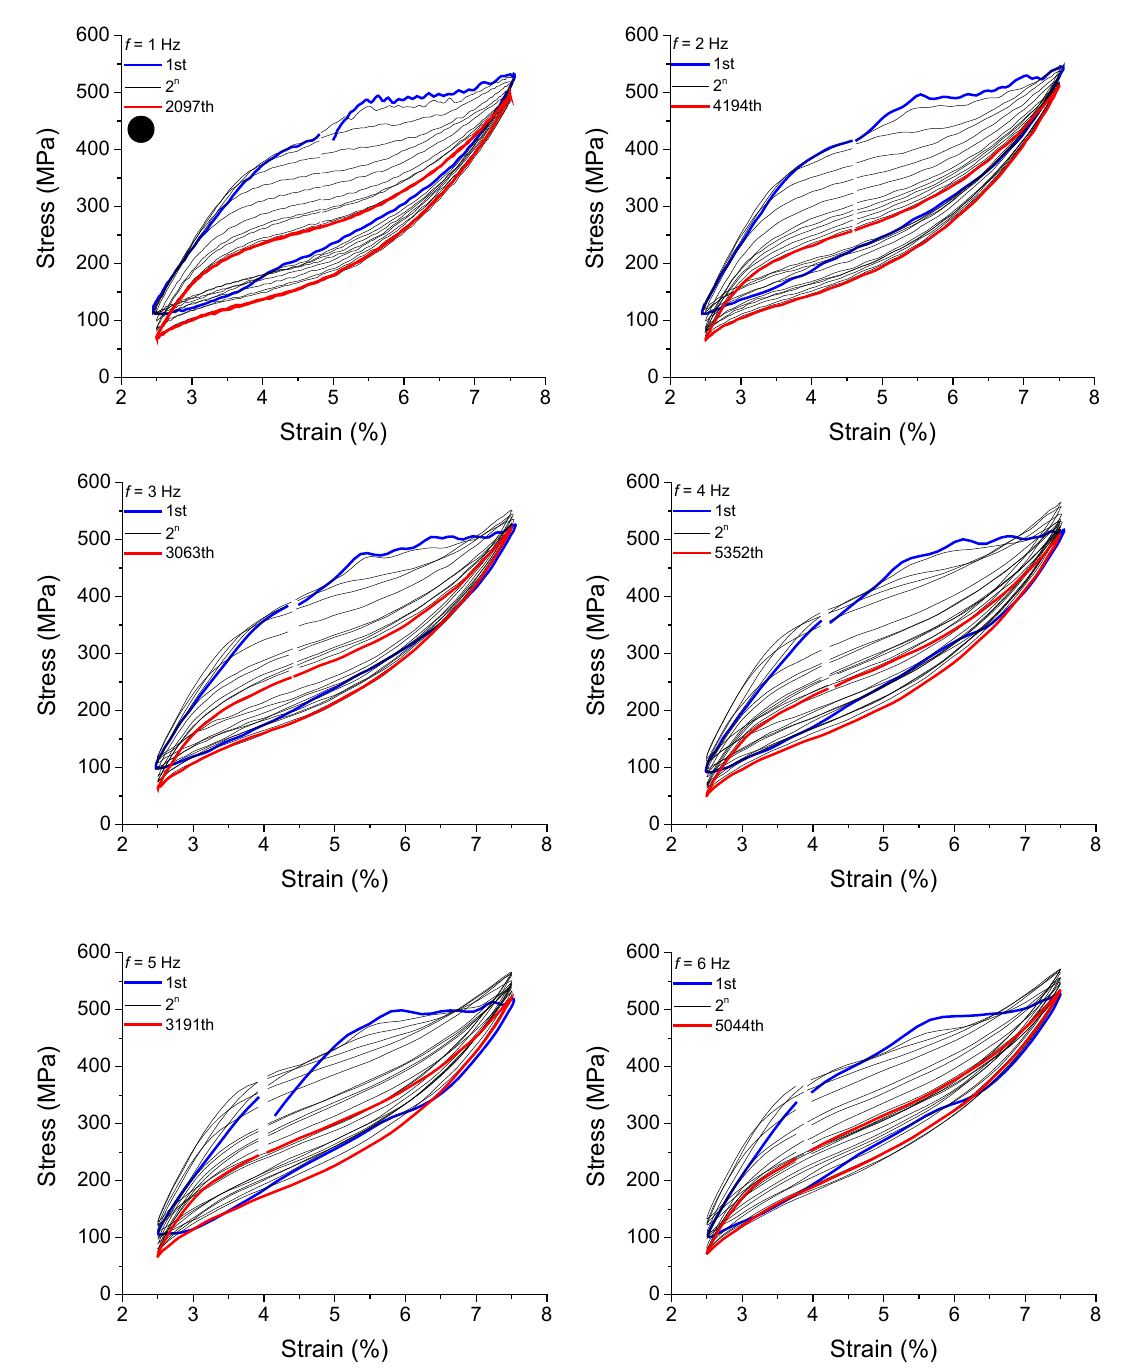
Figure 17. Stress vs. strain superelastic response of the reference element for loading frequencies from 1 Hz to 6 Hz.